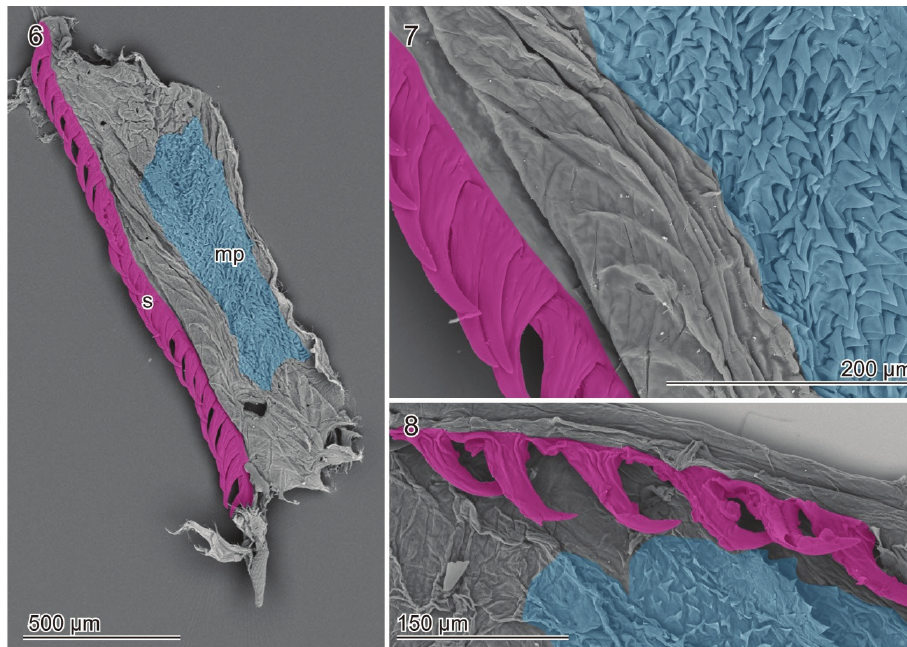
Figures 6–8. The internal sac membrane and spines of Pyrrhalta maculicollis . 6, 7 the sample was cut laterally, opened, dehydrated, and dried at the critical point 8 the sample dried at room temperature. The surfaces of the spines is slightly shrunken in comparison to that depicted in 7. Abbreviations: mp, mem- branous projections; s, spines; each is highlighted with blue and pink, respectively. Table 1. The measurements of the male spines in Pyrrhalta maculicollis , Kanagawa population in Japan.